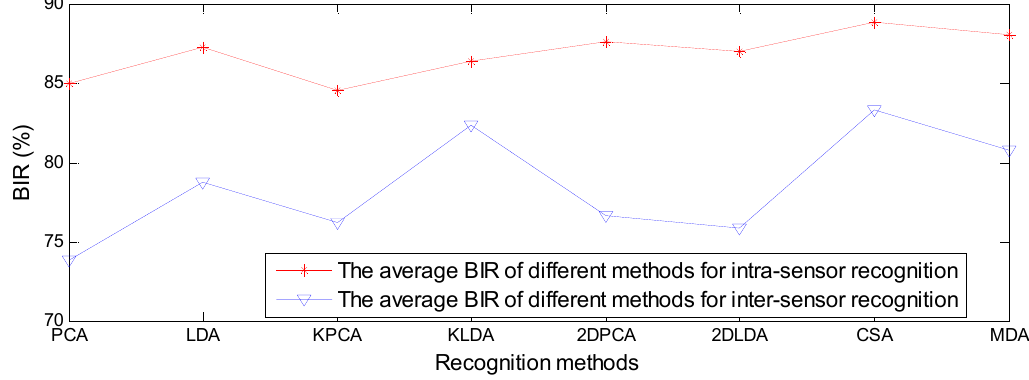
Figure 16. The average BIR comparisons of different subspace learning methods between intra-sensor recognition and inter-sensor